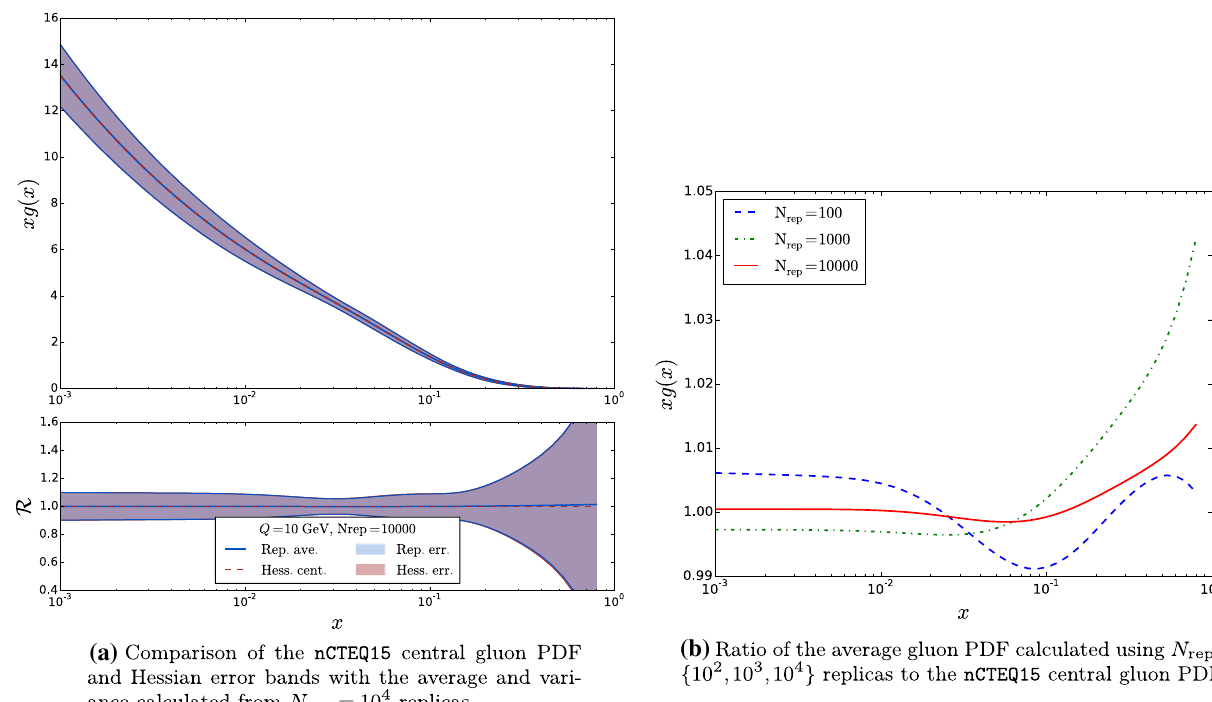
Fig. 16 Comparison of the nCTEQ15 Hessian gluon distribution and its reproduction in terms of replicas at a scale of Q =